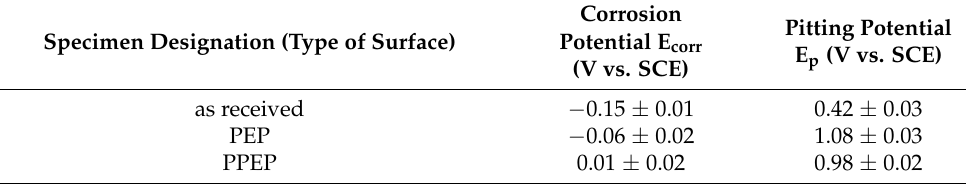
Figure 6. Potentiodynamic polarization curves for tested surface conditions. Table 6. Values of the potentiodynamic polarization